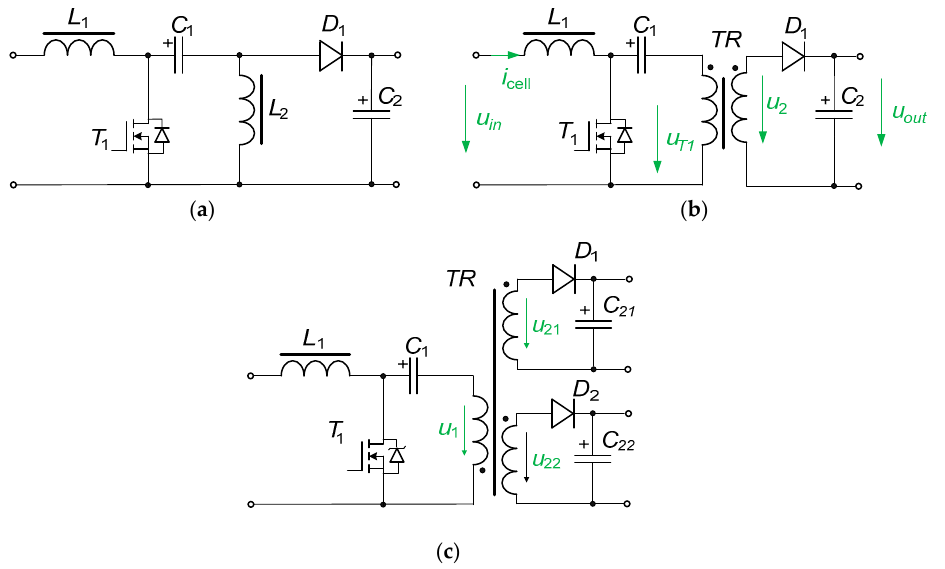
Figure 4. A single-ended primary-inductor converter (SEPIC) cell: ( a ) Typical, ( b ) isolated, ( c ) multiple output.